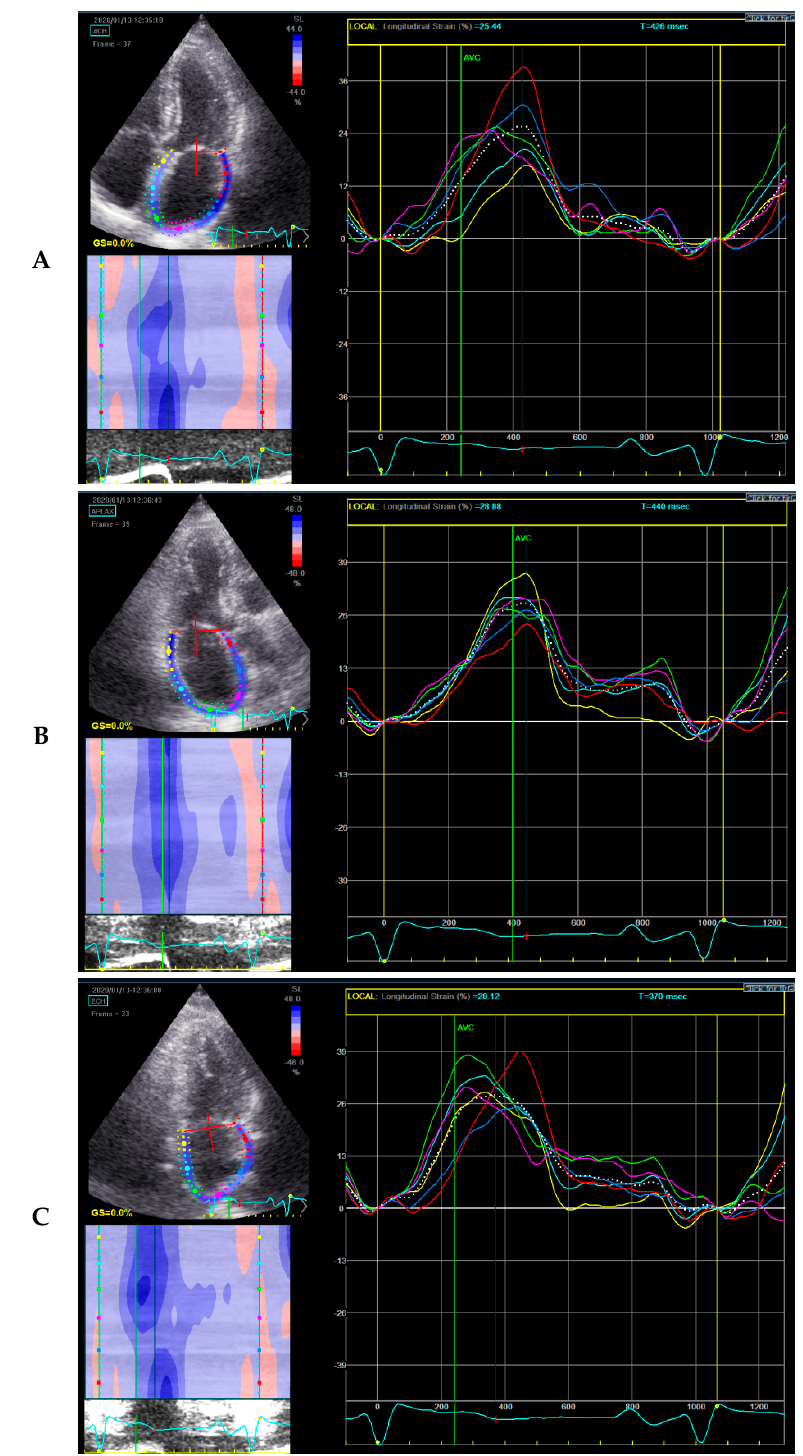
Figure 1. Left atrial strain by two-dimensional speckle-tracking. The area of interest in 4-, 3-, 2- chamber view can be seen in the upper left quadrant of images ( A , B , C ) respectively.